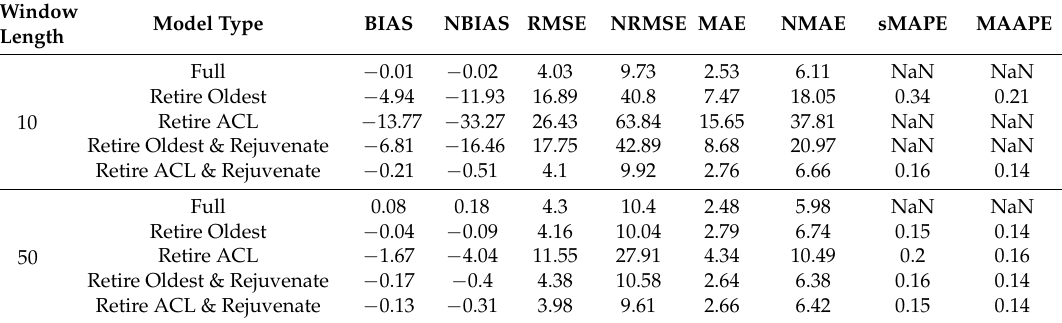
Table 4. One-hour ahead forecasting error evaluation for the different used types of DT with linear model, for rolling windows of 10 and 50 days. BIAS, RMSE and MAE are in the same units as